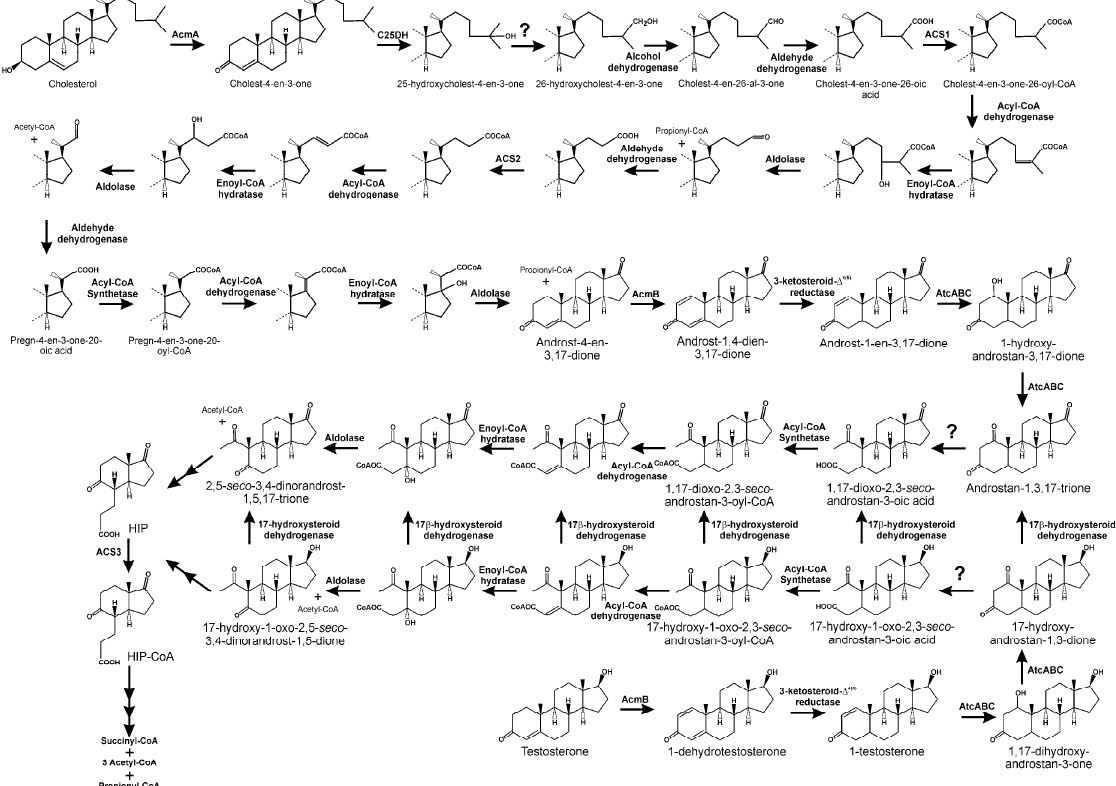
Figure 10. Anaerobic catabolism of cholesterol, in Sterolibacterium denitrificans , and testosterone, in Steroidobacter denitrificans , by the 2,3- seco pathway. Putative points of convergence between both metabolic mechanisms are also suggested.